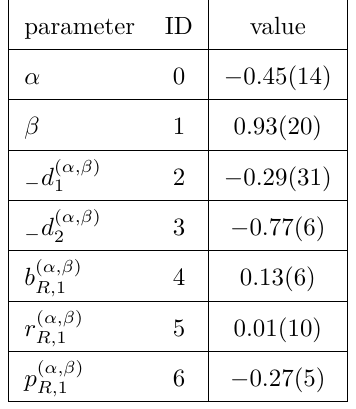
Table 5 . The values of the parameters from fitting the real component to the model “default”. The ID numbers correspond to the labels in figure